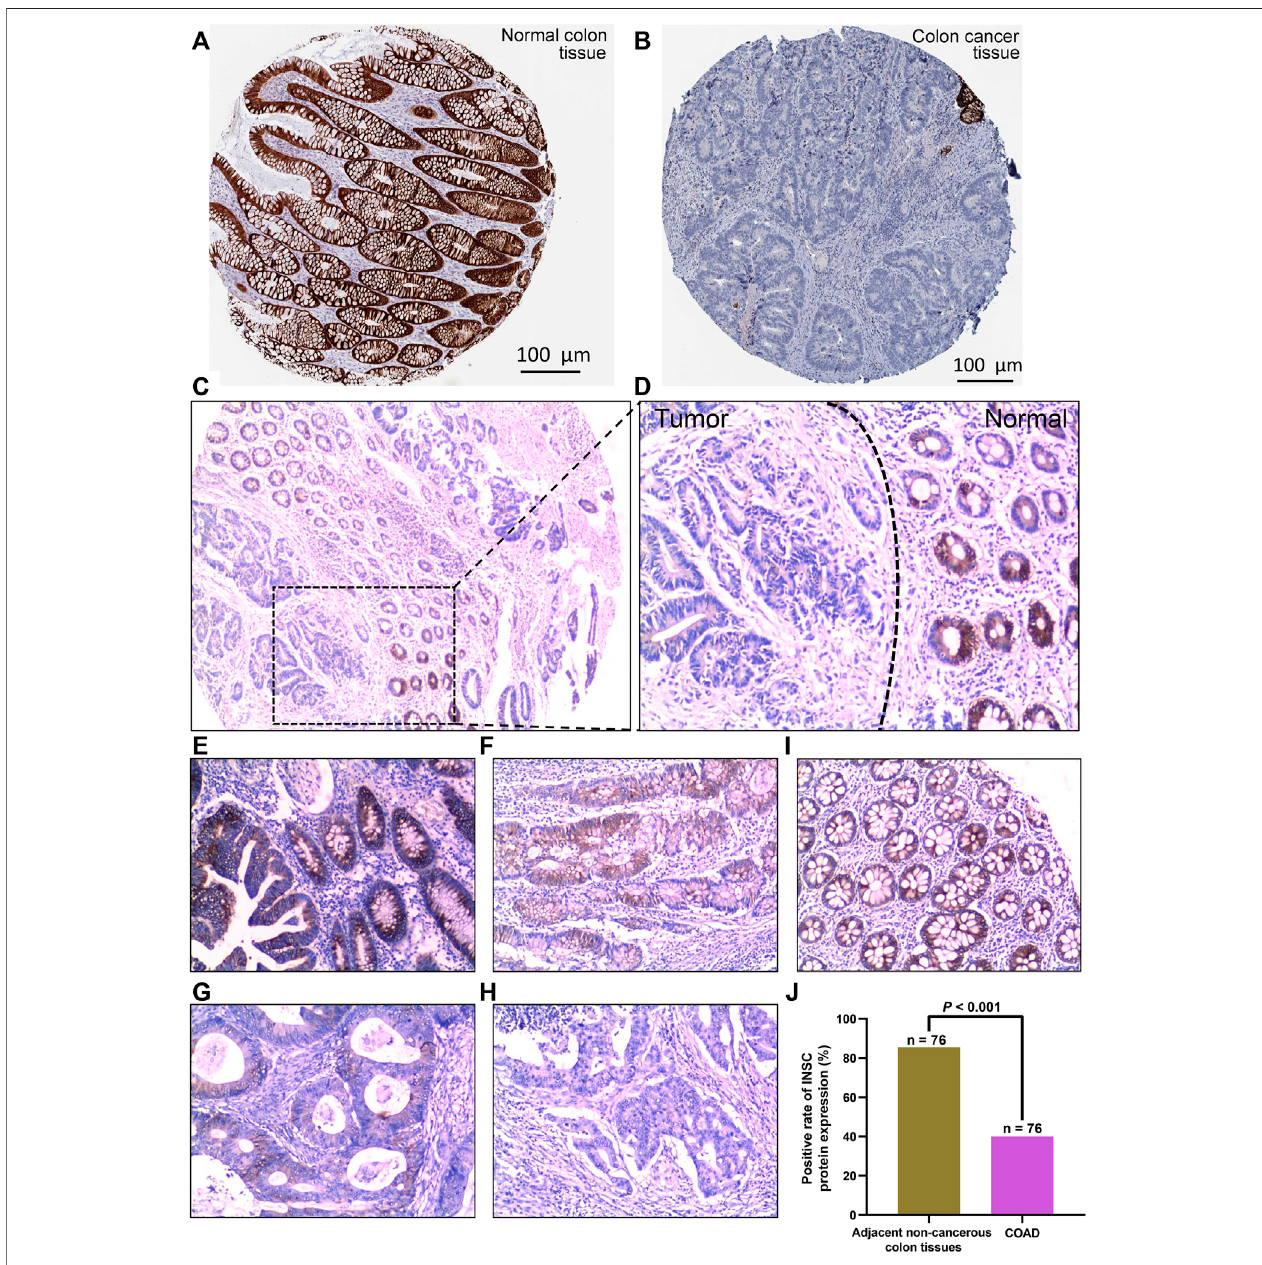
FIGURE 2 | INSC expression in normal colon and COAD tissues was determined by immunohistochemistry. The level of INSC protein in COAD (A) and normal tissues (B) (Antibody HPA039769) form the HPA database; (C) INSC protein expression in COAD and non-cancerous colon tissues and its immunohistochemical staininginrepresentativetissuespecimens.Originalmagni fi cation,×40; (D) immunohistochemicalstainingofINSCproteinsinrepresentativeCOADandnon-cancerous colon specimens. The left side represents cancer tissues and the right side represents non-cancer tissues. Original magni fi cation, ×100; (E – H) the score of INSC expression in representative tumor cells of COAD ((E) score = 3, (F) score = 2, (G) score = 1, and (H) score = 0); magni fi cation, ×100; (I) expression of INSC in representative normal colon cells ((I) score = 3); magni fi cation, ×100; (J) positive rate of INSC protein expression in adjacent non-cancerous colon tissues and COAD tissues ( p < 0.001, cancer vs . non-cancerous tissues, chi-squared test), n = 82, and six samples were